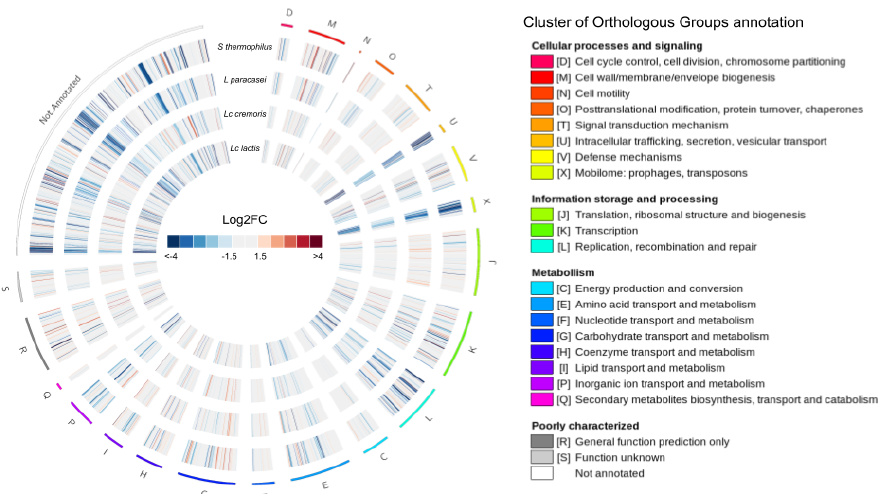
Figure 3. Circular representation of the di ff erentially expressed genes (DEGs) in each of the functional categories. The Cluster of Orthologous Groups of proteins (COG) categories and the log2FC of the genes in each category are indicated. From outside to inside, we have the DEGs for L. paracasei CNCM I-3689, L. lactis subsp. lactis CNCM I-1631, L. lactis subsp. cremoris CNCM I-3558, and S. thermophilus CNCM